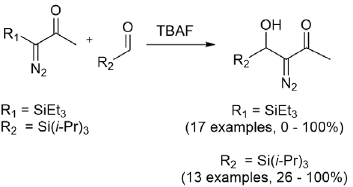
Figure 47 - TBAF-Induced Aldol-Type Addition of TES- Diazoacetone and Mukaiyama Aldol-Type Addition of TIPS- diazoacetone to a range of